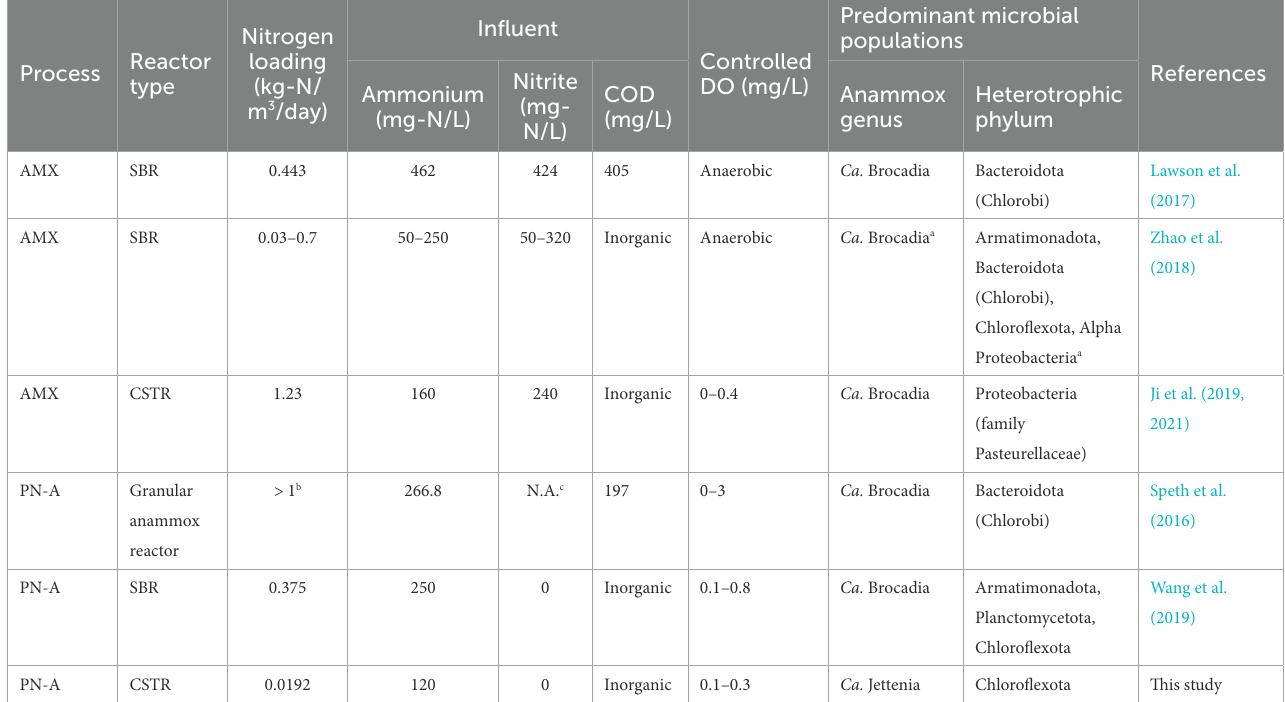
TABLE 1 Influential and dominant MAGs from metagenomic analyzes of anammox and single-stage PN-A reactors.